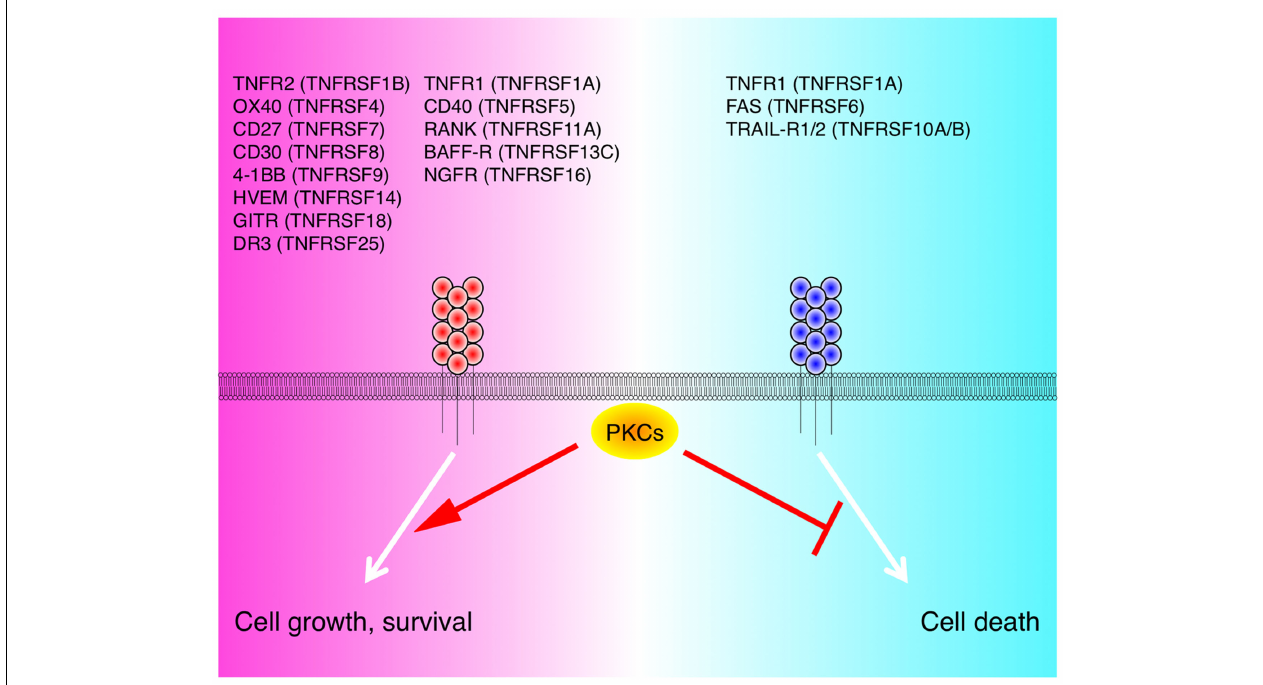
FIGURE 2 | PKC isoforms control life and death induced byTNFRSF. TheTNFR-PKC axis activates NF- κ B1 or other signaling pathways, which concomitantly promotes cell growth/survival and inhibits cell